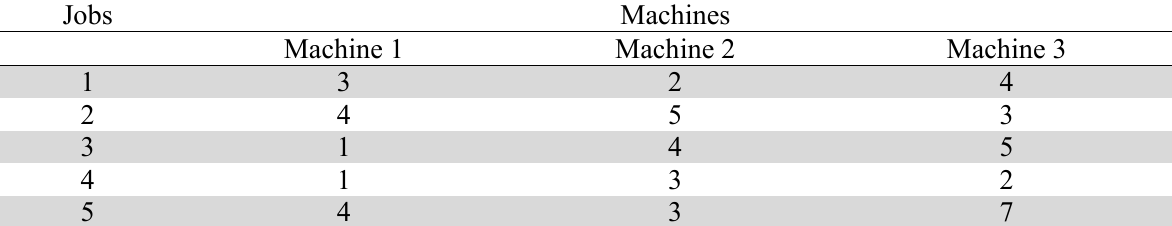
Flow shop scheduling